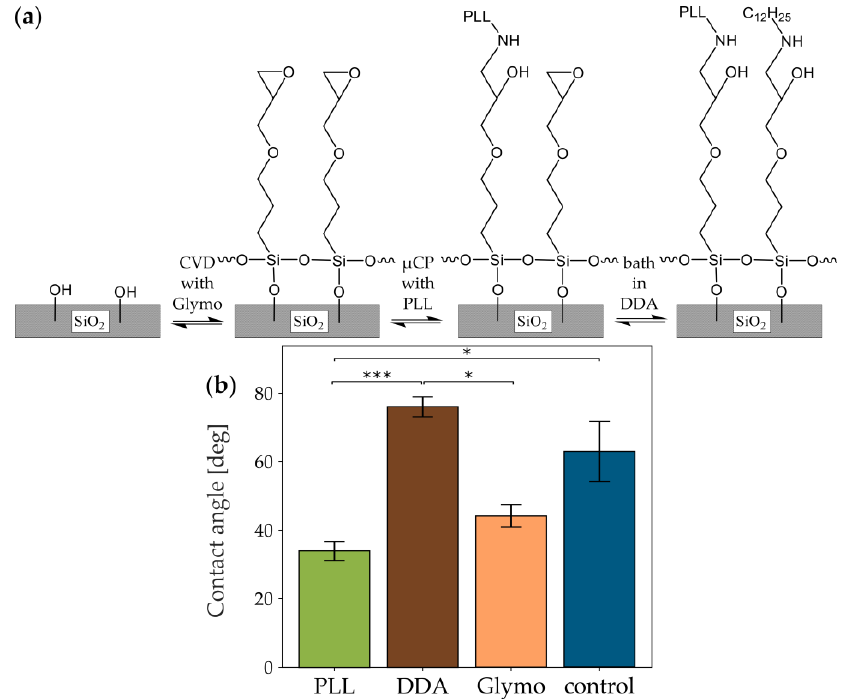
Figure 4. Theory and effect of glass treatment with Glymo and different secondary molecules. ( a ) Reaction schematics of the Glymo-based modification of idealized glass. First, Glymo is applied by CVD followed by the binding of PLL via µCP. Finally, DDA is bound to the unbound epoxy groups of Glymo. Alternatively, Glymo remains unbound in a washing step with EtOH. ( b ) Difference of contact angle between glass with Glymo and a homogeneous secondary treatment with PLL, DDA, or EtOH, and untreated glass (control). Color code of the bars corresponds to Figure 1. Statistical significance was tested for all samples with the Kruskal-Wallis H-test for independent samples (p = 0.0001; n = 6). For individual comparison, Dunn’s multiple comparison test with Bonferroni correction was used (p PLL/DDA = 9.05e −5 ; p PLL/EtOH = 0.9183; p PLL/control = 0.0225; p DDA/EtOH = 0.0225; p DDA/control = 0.9183; p EtOH/control = 0.8499).